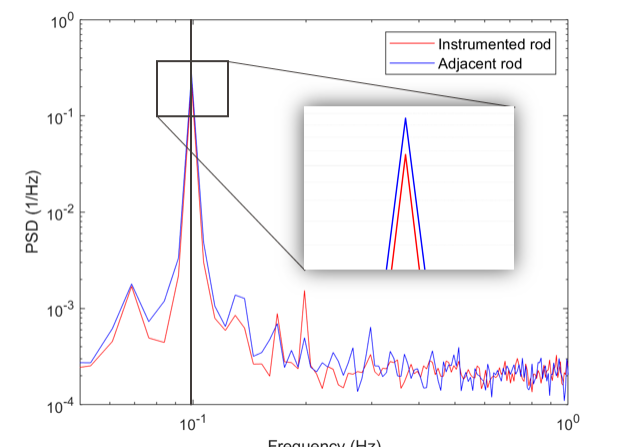
Fig. 7. Auto power spectral densities obtained with the miniature neutron scintillator for the oscillation of the instrumented fuel rod (red), and its adjacent one